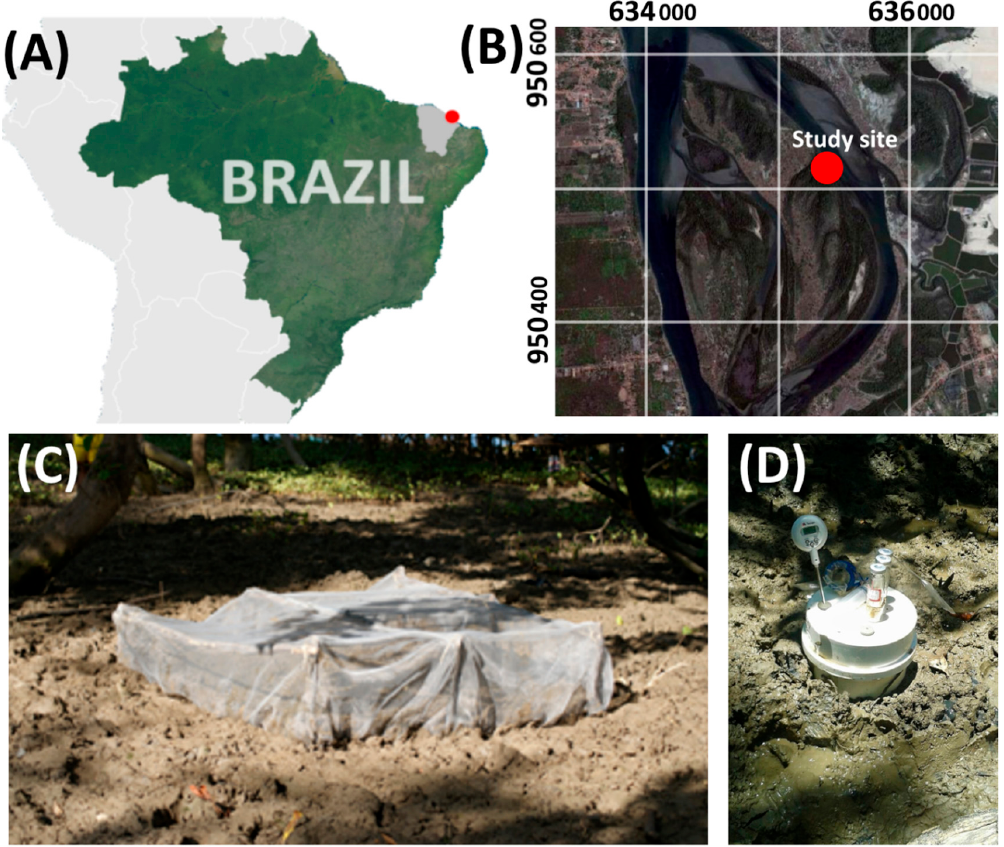
Figure 1. ( A ) Location of the studied mangroves in Brazil, ( B ) location of the sampling sites, ( C ) crab-exclusion plot, and ( D ) static chambers used for N 2 O collection.